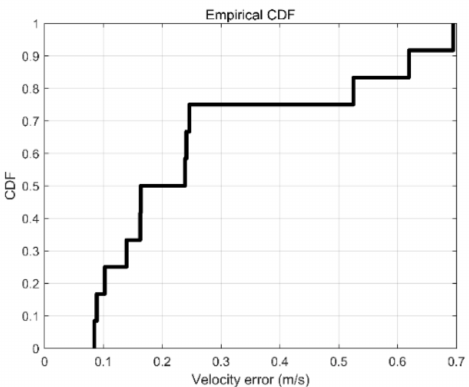
Figure 13. The cumulative density function of the speed detection